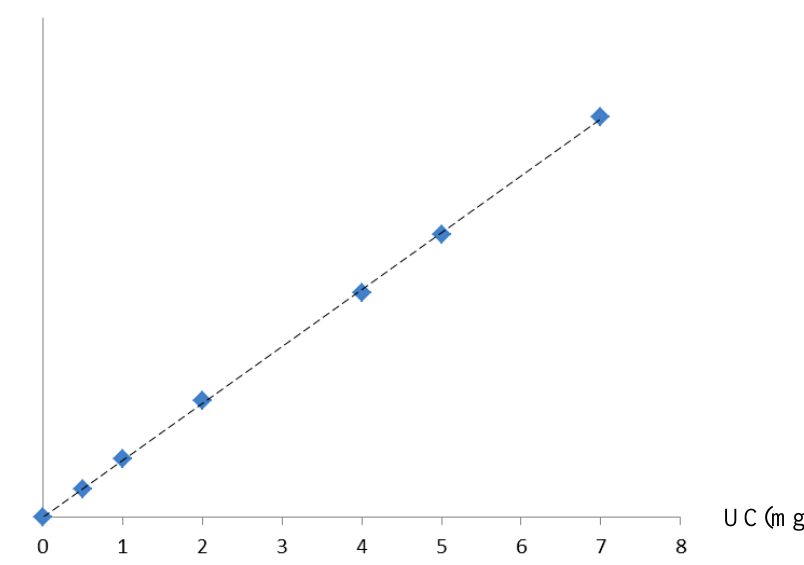
Fig. 4: Calibration curve of between uranium concentration (mg/l) and intensity [5]. Results and discussion